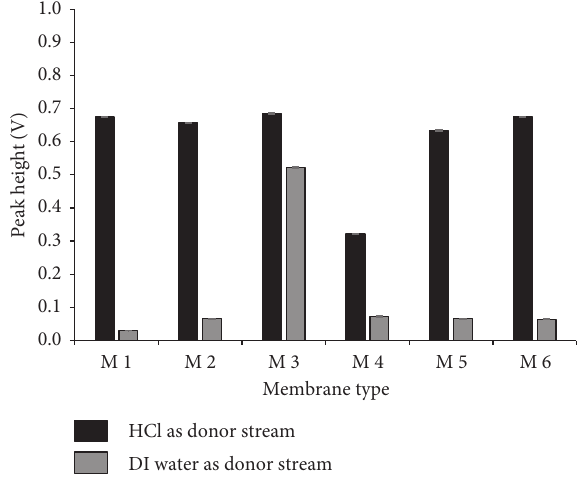
Figure 4: Influence of the membrane types on peak height